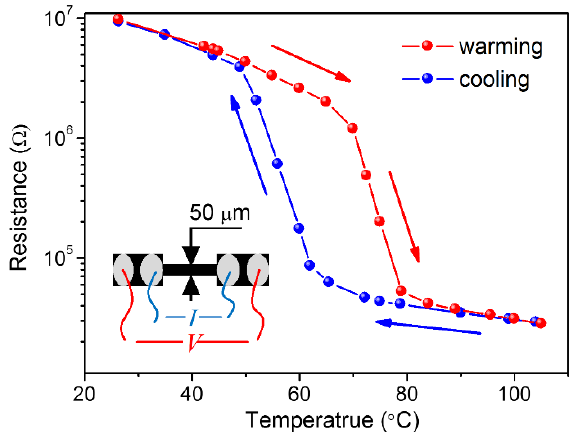
Figure 5. R – T curve of patterned VO 2 ceramic film.